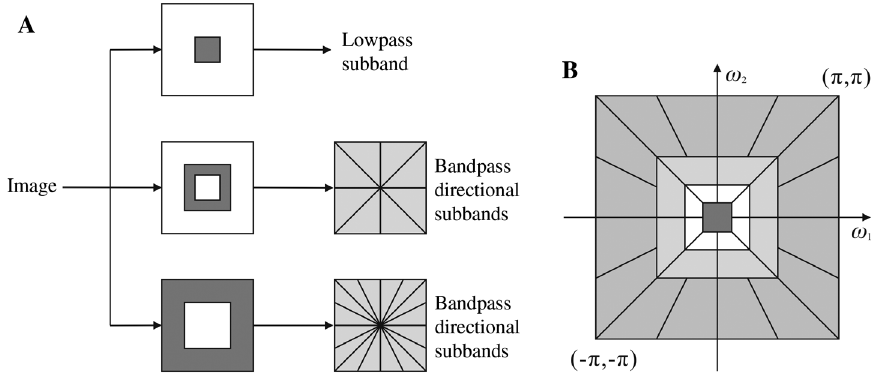
Figure 1. Nonsubsampled Contourlet Transform.